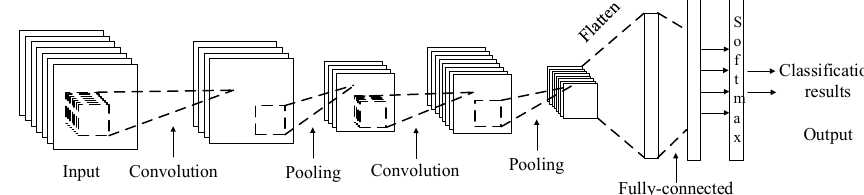
Figure 2. Common structure of a convolutional neural network (CNN).